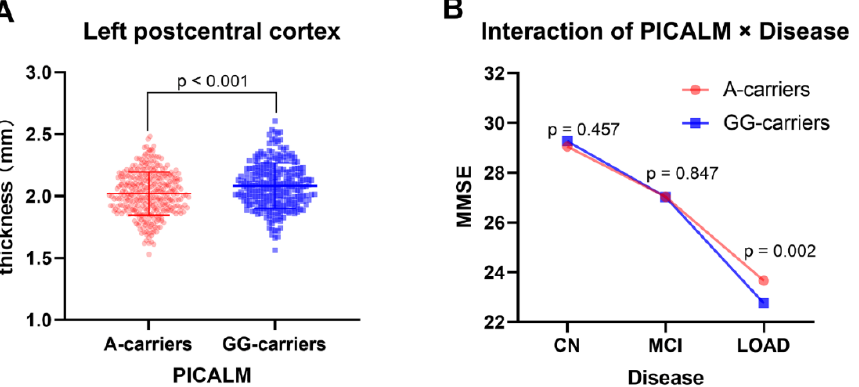
Figure 2. The main effect of PICALM on left postcentral cortex and the interaction of PICALM and Disease on MMSE. Note: ( A ), the thickness of left postcentral cortex was extracted from A-carriers and GG-carriers. The mean value of GG-carriers is higher than that of A-carriers. ( B ), the interactive effect of PICALM and Disease on MMSE is significant (F = 4.539, p = 0.011). In LOAD patients, a higher MMSE score is found in A-carriers, compared with GG-carriers ( p = 0.002). While in CN or MCI patients, MMSE is not significant different between A-carriers and GG-carriers ( p = 0.457, 0.847, respectively). The MMSE score decreases significantly in both A-carriers and GG-carriers, from CN to MCI to LOAD.